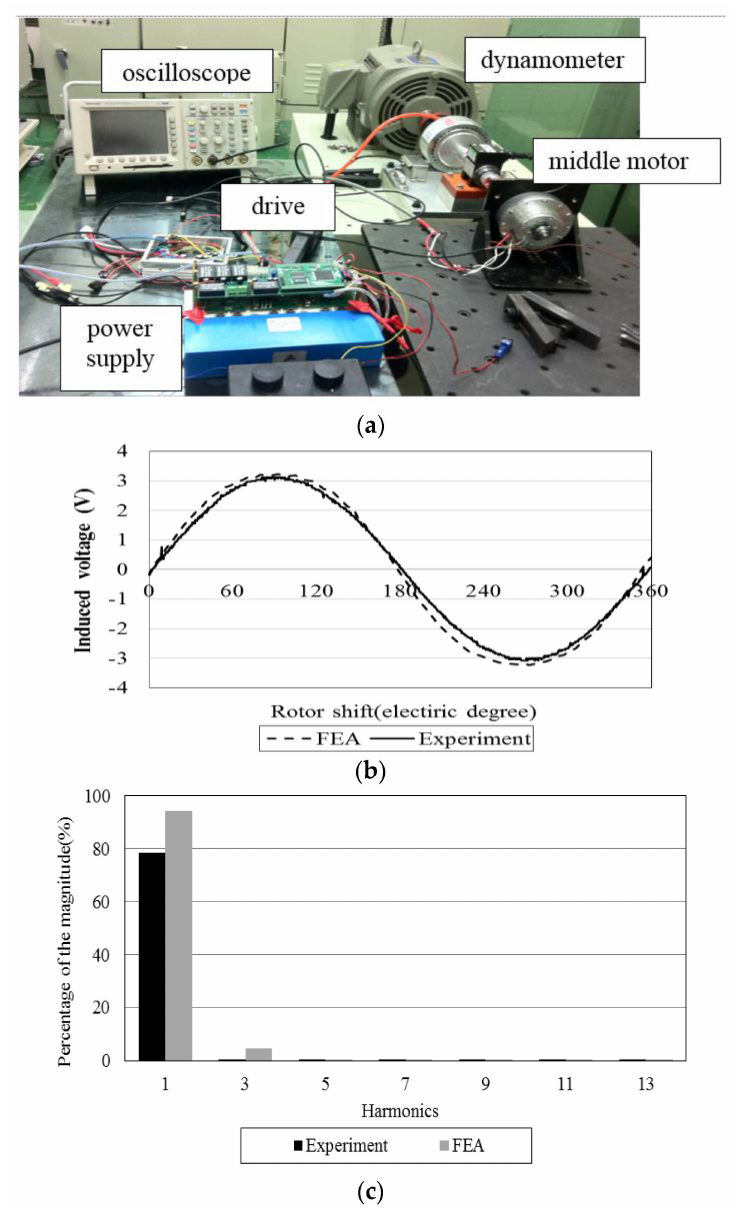
Figure 11. ( a ) Experimental setup; ( b ) comparison of the back emf (at 500 rpm) and ( c ) its harmonics from the FE analysis and